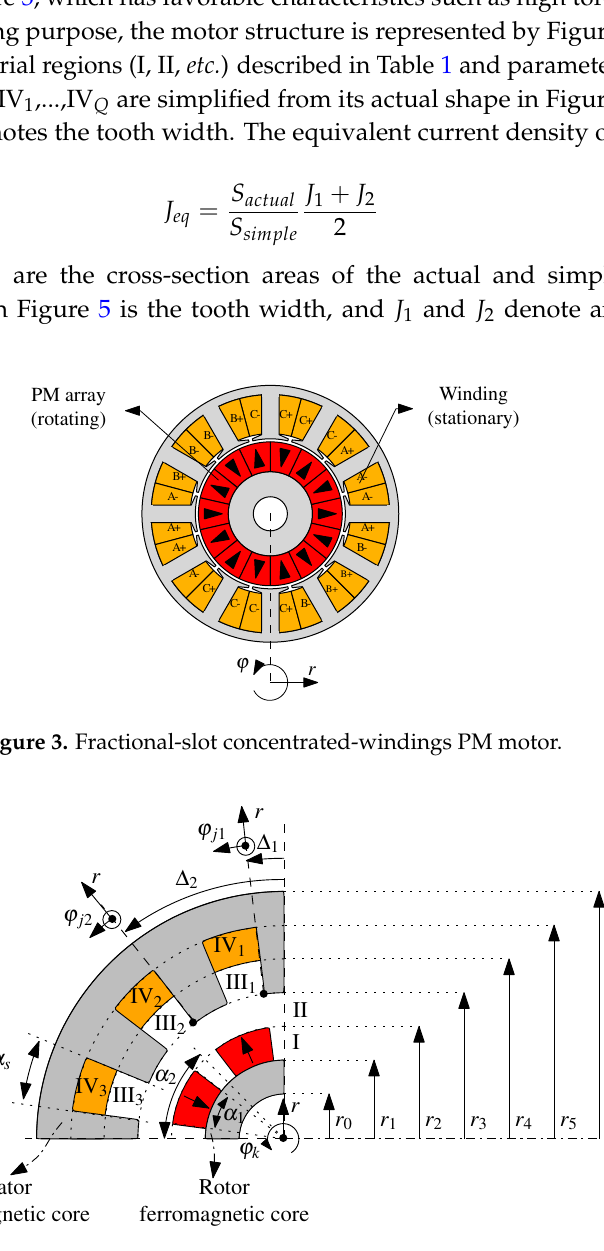
Figure 4. Representation of the electrical motor structure for modeling